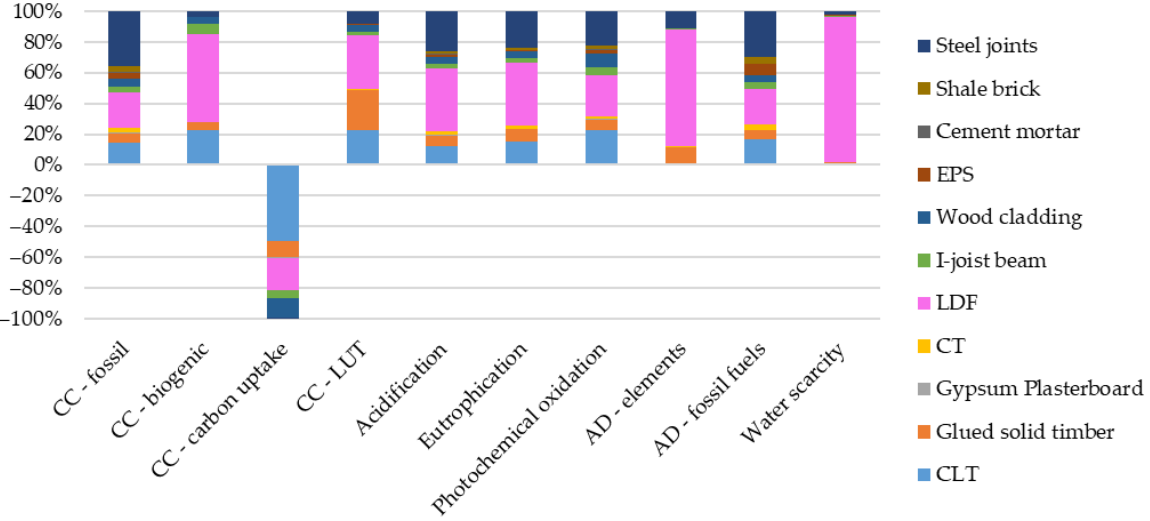
Figure 12. Impact assessment of peripheral wall construction materials.